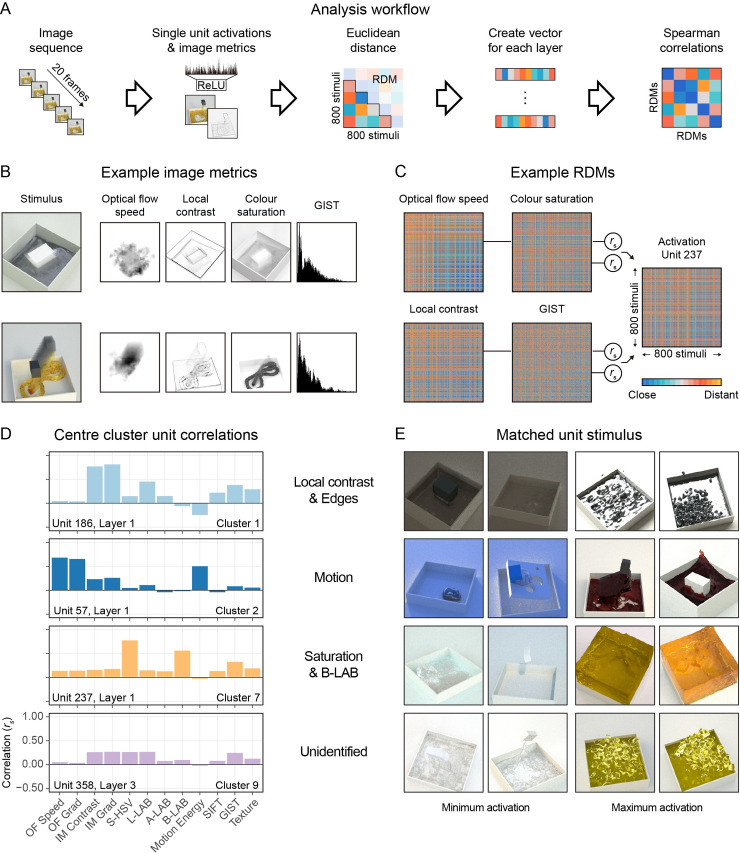
(A) RSA workflow for unit-level analysis. (B) Two stimuli with examples of the resulting image metric output. The ghosting effect shows motion over time. The multi-feature metrics such as Motion Energy and GIST lose the spatial structures. (C) Example RDMs of the same image metrics as B. Each row/column represents a stimulus, and colours indicate the distances between each pair of stimuli in terms of the corresponding image metric. Each RDM is correlated with the activation RDM of a single unit, in this case unit 237. (D) A selection of the RSA correlations for the units closest to the centres of four of the clusters shown in Fig 6. (E) The two stimuli of the entire dataset that created the minimum and maximum activation responses for the units of D.